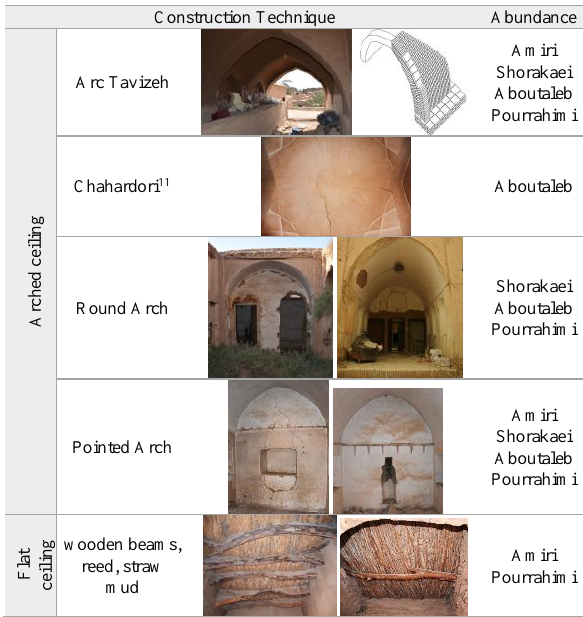
Table 4. Construction Method of 4 case studies of Muzaffarid Houses. Reference: